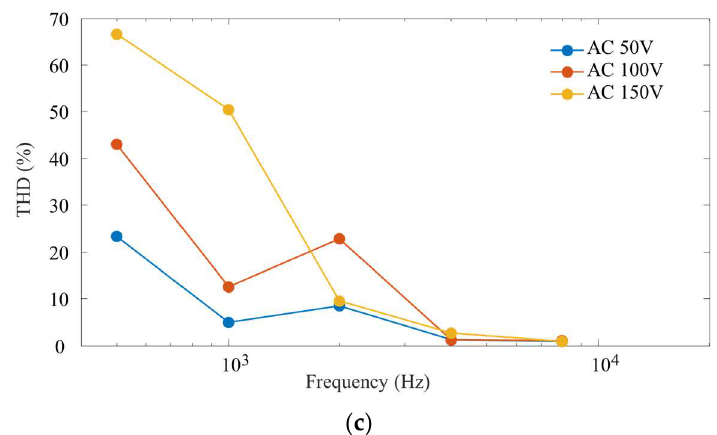
Figure 7. Transfer functions between the pressure measured using a microphone placed directly on-axis to the DEAP loudspeaker and the amplifier’s monitor voltage output: ( a ) effect of varying the bias voltage while the alternating voltage is kept constant at 100 V; ( b ) effect of varying the alternating voltage while the bias voltage is kept at 800 V; and ( c ) total harmonic distortion for bias voltage of 800 V at different alternating voltages.